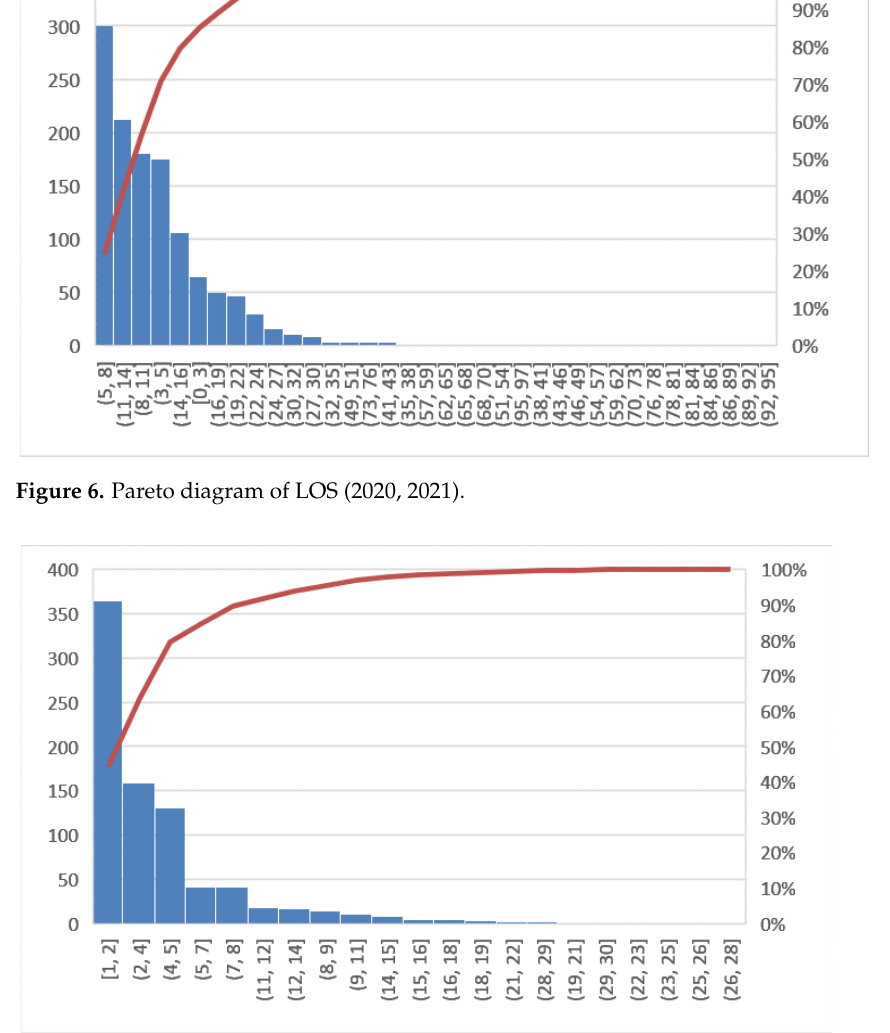
Figure 7. Pareto diagram of number of DH admission (2020, 2021).